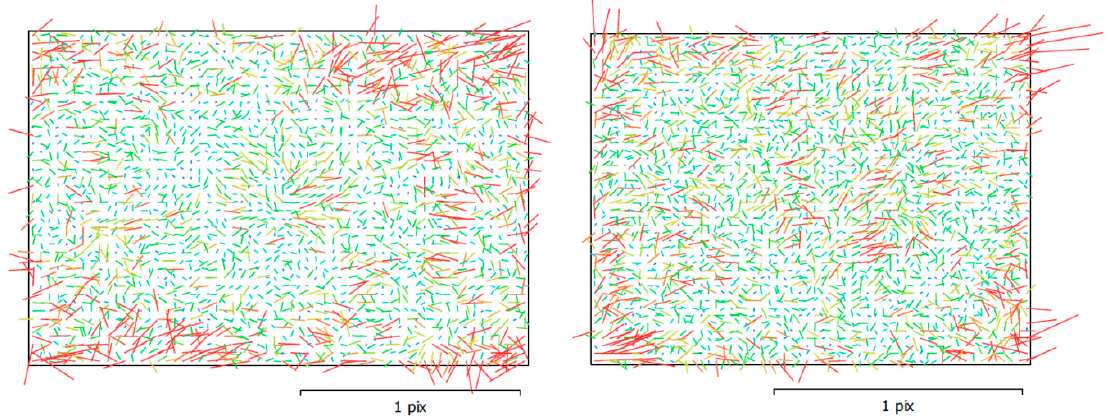
Figure A1. Image residuals for Sony A7 (left) and Lumix TZ7 (right) side after image-matching processing.